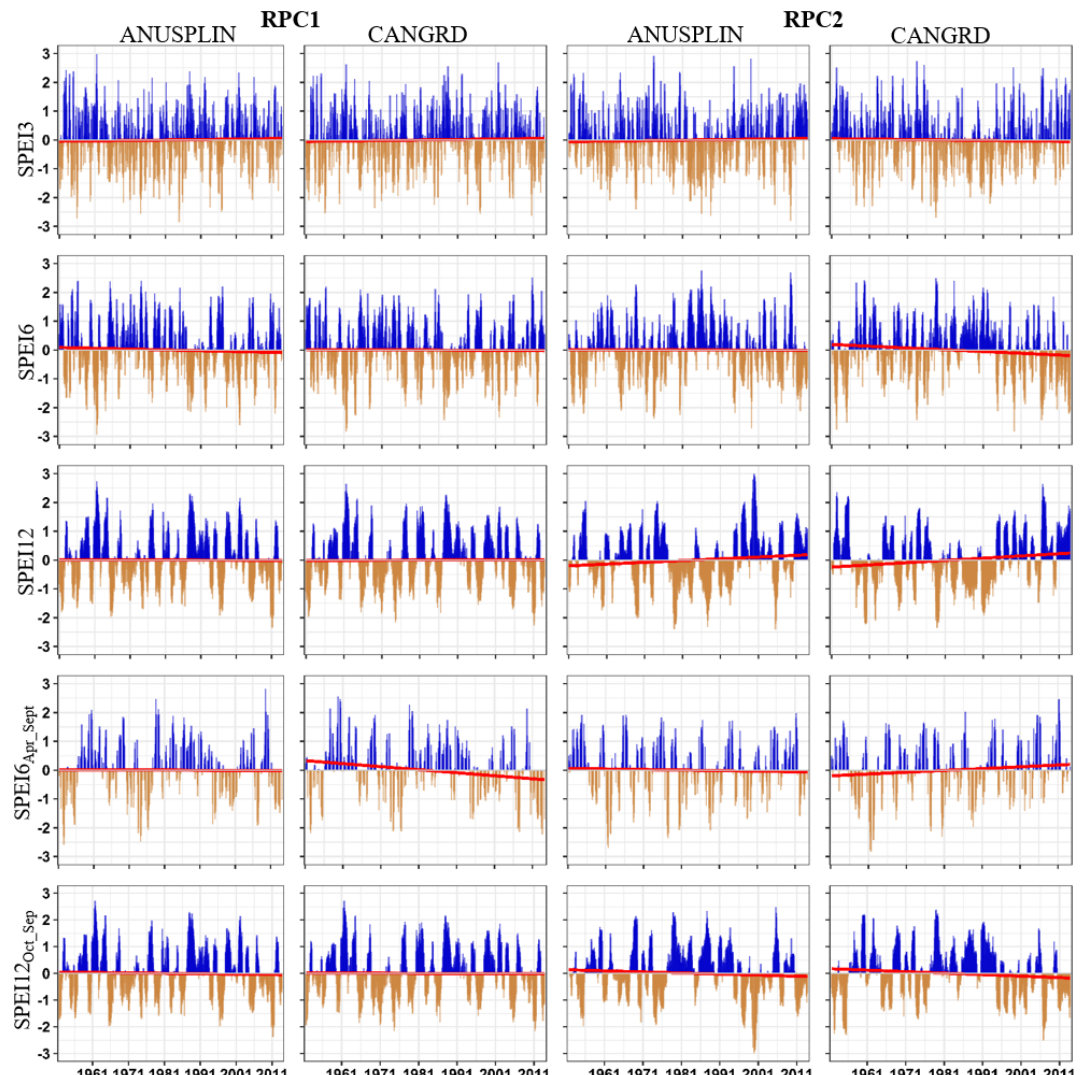
Figure 7. Long-term (1950–2013) trends (red line) of the RPCs for each drought subregion and data